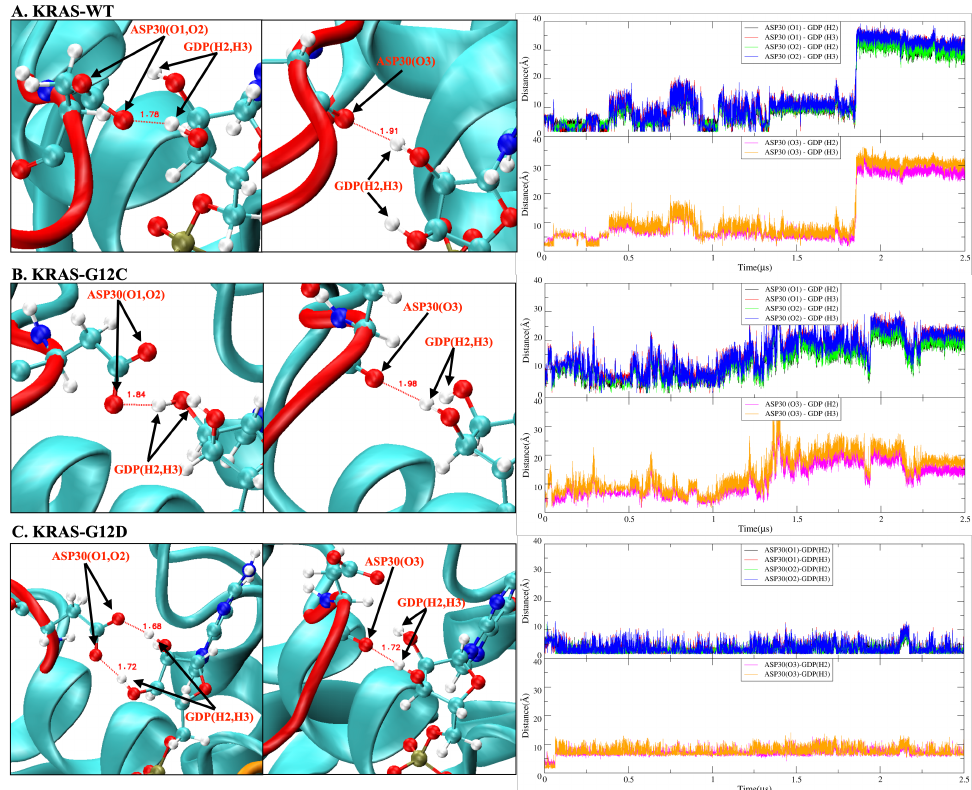
Figure A8. The hydrogen bond interaction between ASP30 of KRAS and GDP. ( A ) KRAS-WT case. Left side: representative snapshot of HB ASP 30 ( O 1/ O 2 ) − GDP ( H 2/ H 3 ) and HB ASP 30 ( O 3 ) − GDP ( H 2/ H 3 ) , right side: time evolution of atom–atom distance d ( t ) corresponding to the left side; ( B ) KRAS-G12C case. Left side: representative snapshot of HB ASP 30 ( O 1/ O 2 ) − GDP ( H 2/ H 3 ) and HB ASP 30 ( O 3 ) − GDP ( H 2/ H 3 ) , right side: time evolution of atom-atom distance d ( t ) corresponding to the left side; ( C ) KRAS-G12D case. Left side: representative snapshot of HB ASP 30 ( O 1/ O 2 ) − GDP ( H 2/ H 3 ) and HB ASP 30 ( O 3 ) − GDP ( H 2/ H 3 ) , right side: time evolution of atom–atom distance d ( t ) corresponding to the left